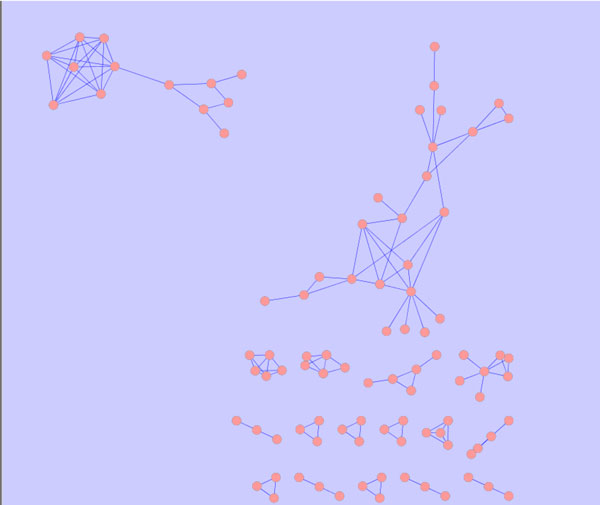
Reaction network.